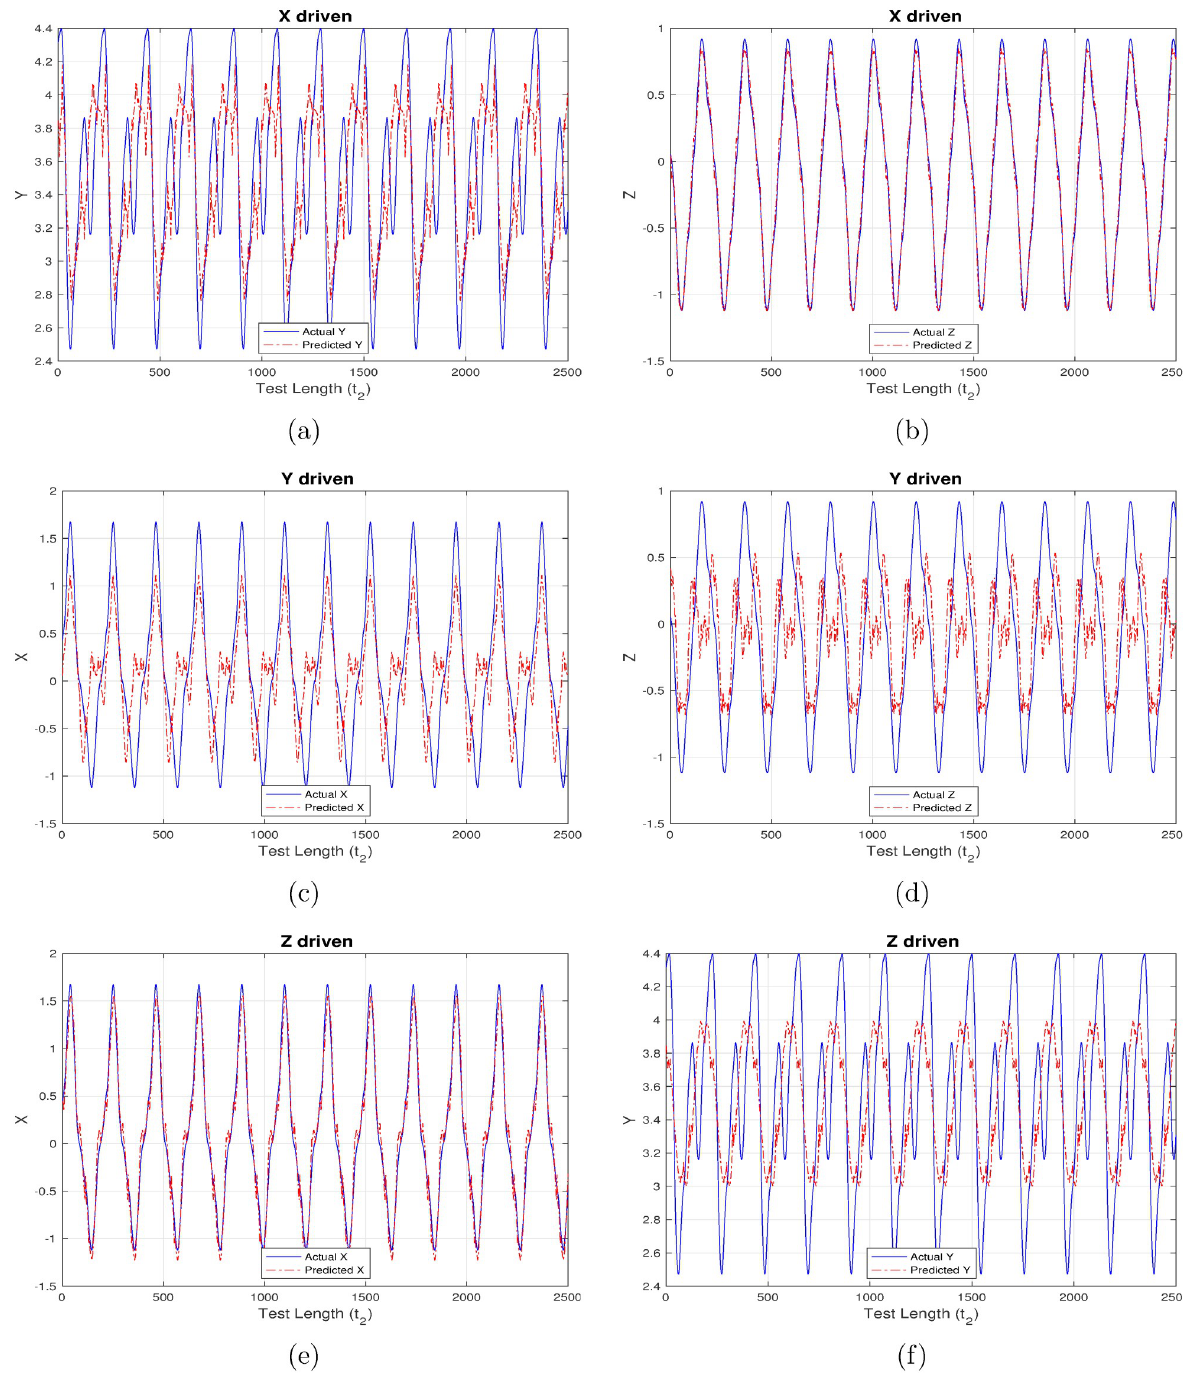
Fig 8. Controlled (time-delayed feedback) financial system component re-generation using “linear” activation. (a) Re-generating “investment demand” [Y] behavior with “interest rate” [X] as input (b) Re-generating “price index” [Z] behavior with “interest rate” [X] as input (c) Re- generating “interest rate”[X] behavior with “investment demand”[Y] as input (d) Re-generating “price index” [Z] behavior with “investment demand” [Y] as input (e) Re-generating “interest rate” [X] behavior with “price index” [Z] as input (f) Re-generating “investment demand” [Y] behavior with “price index” [Z] as